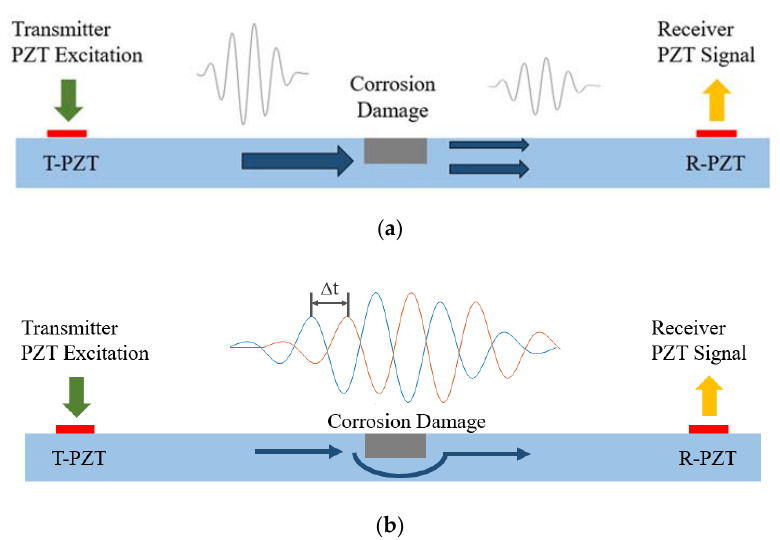
Figure 3. Illustration of changes for Lamb waves passing through a corrosion. ( a ) Amplitude change, ( b ) phase change.